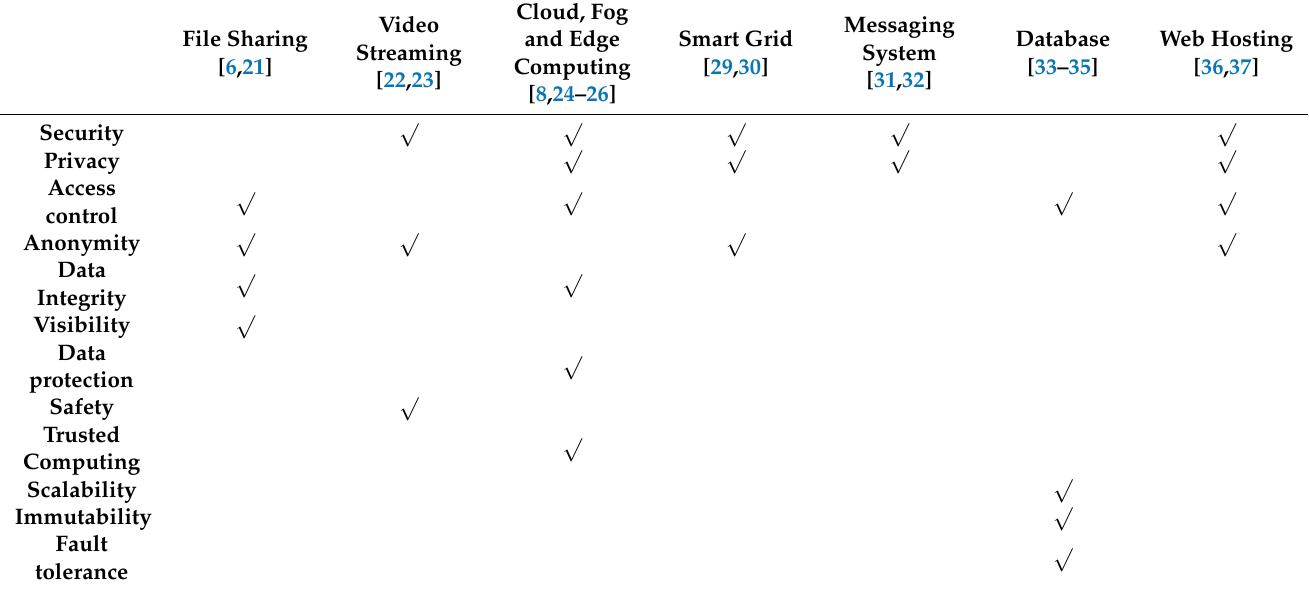
Table 1. Applications and blockchain